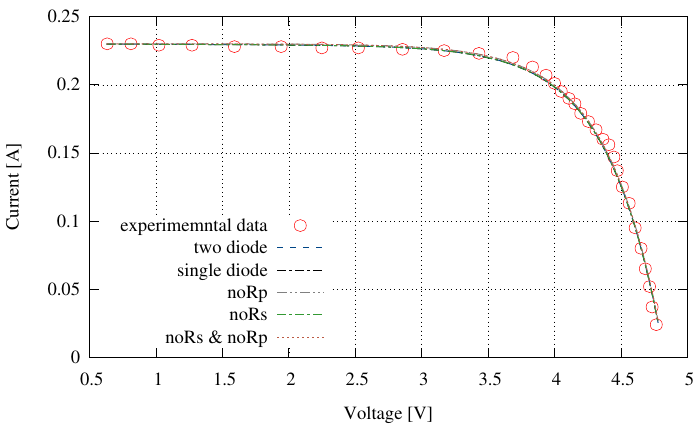
Figure 5. Results of model tuning for Multicomp MC-SP-0.8 PV module.